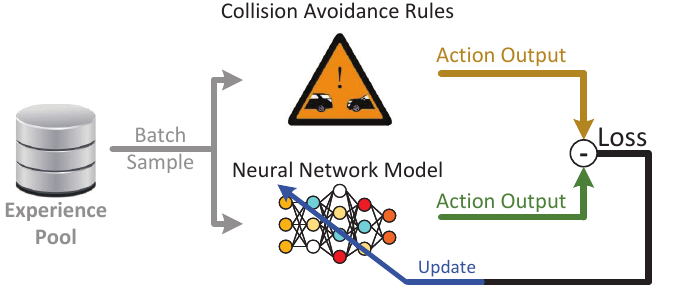
Figure 2. Imitation Learning for Motion Control.